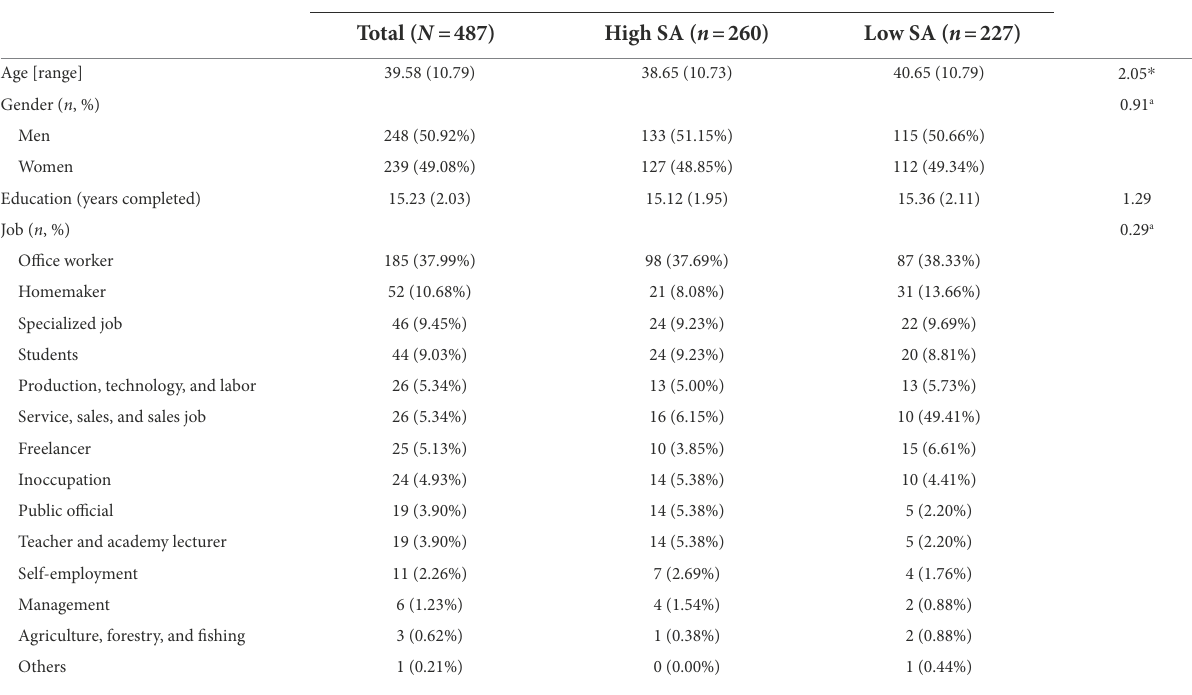
TABLE 1 Demographic characteristics.